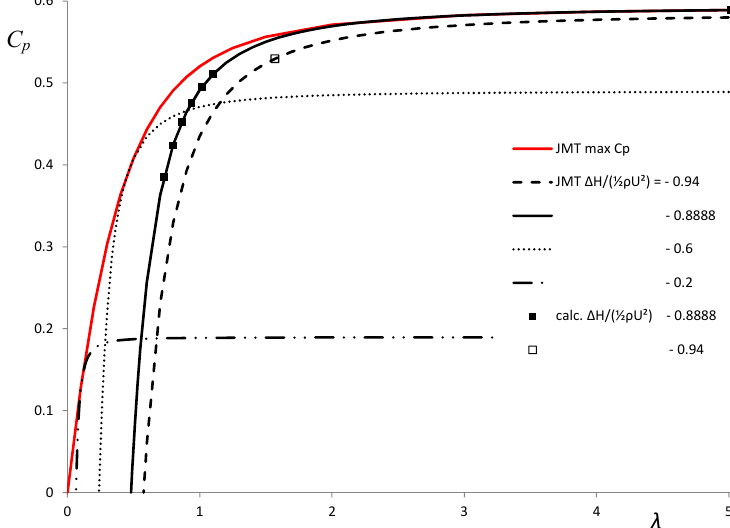
are van Kuik and Lignarolo (2016). This is confirmed by the calculations: the force in x direction resulting from the pres- sure integrated along the wake boundary for − 25 < x/R < 25 is 0.2 % of the non-conservative disc load (cid:49)HπR 2 . However, when applying Eq. (21) per annulus, the pressure acting at the boundaries of the annulus has to be added, so the second term in Eq. (21) is expanded to become H ( p − p 0 )2 πr d r , where S is the contour in the meridian S plane of the annulus control volume: The pressure integral is calculated with x/R = ± 25 R as up-